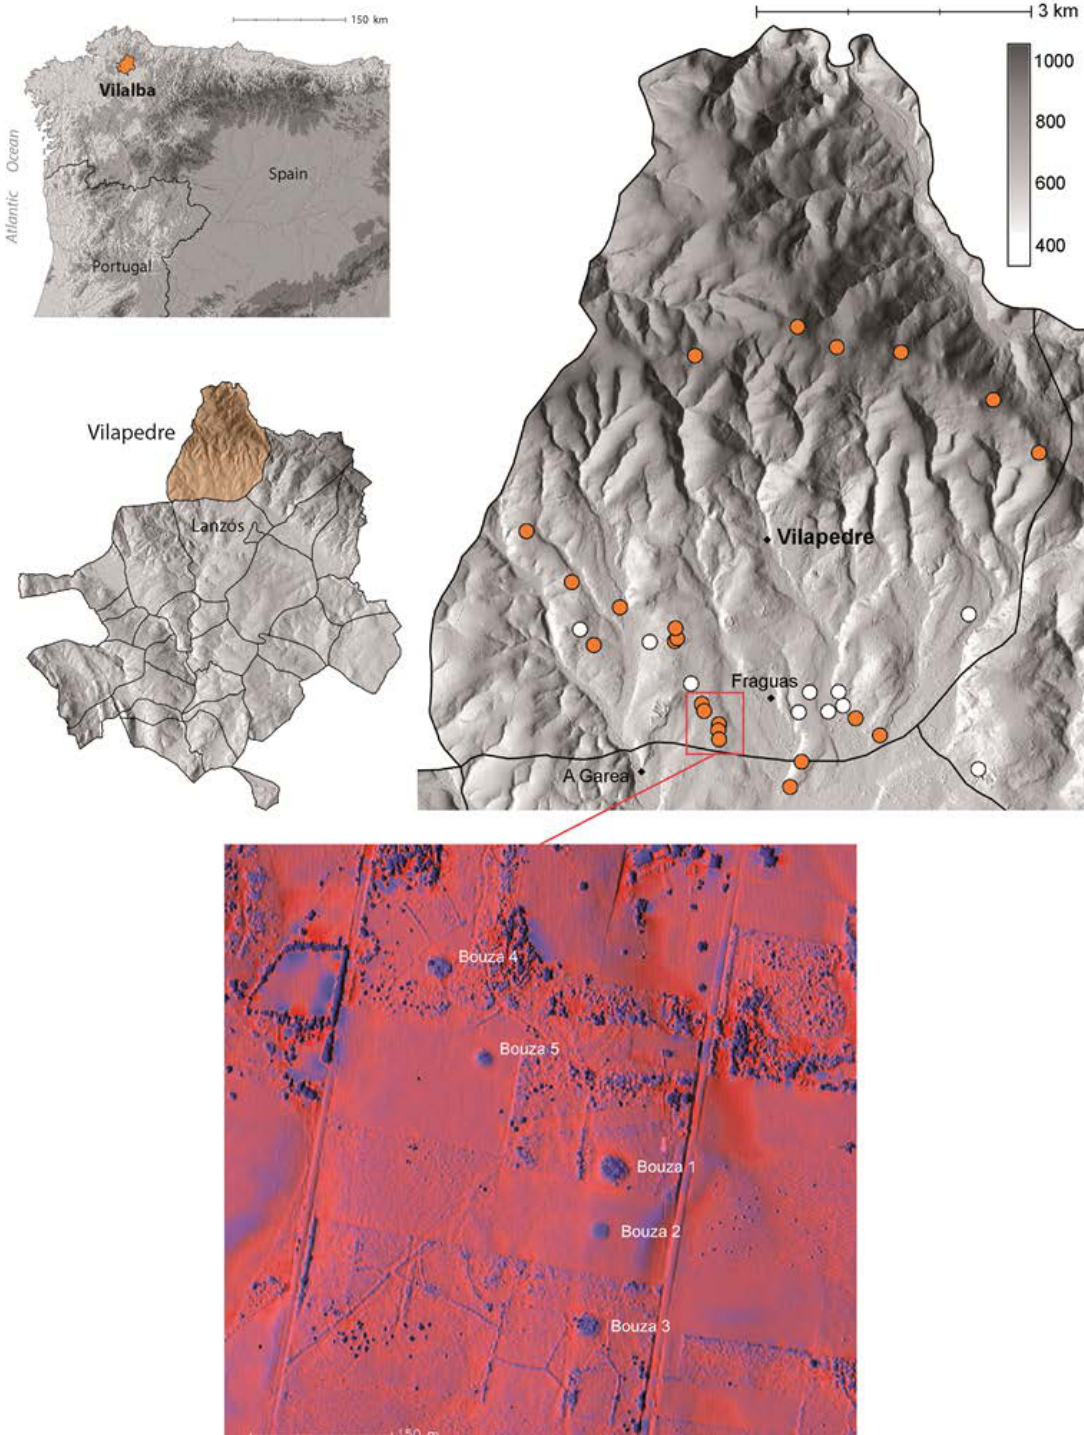
Figure 4. Location of the Vilalba council and Vilapedre parish (Lugo) (top left). Catalogued mounds either preserved (orange) or destroyed (white) (top right). Map showing the location of the Bouza or Veiga da Garea necropolis (bottom). Mapping C. Rodríguez. LiDAR data (max.res. c. 0.5 points/m 2 ) PNOA. Instituto Geográfico Nacional. Spain. GRASS GIS v.